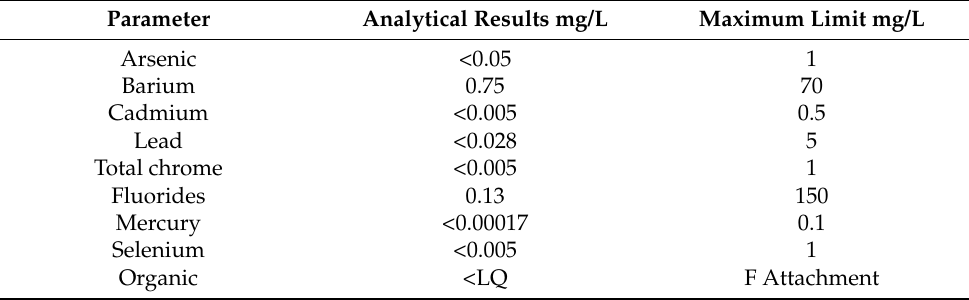
Table 7. Analysis of leachate extract from